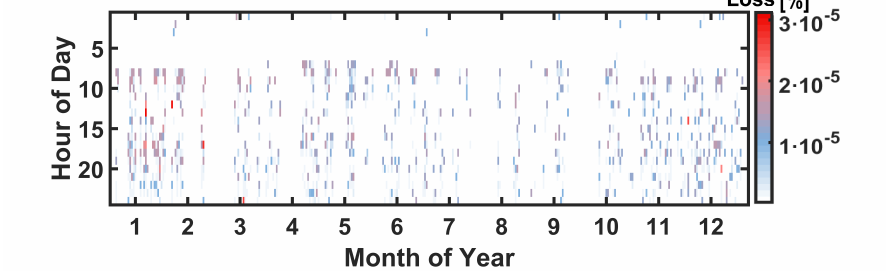
Figure 24. Hourly mean total loss increment for Scheme 2 (Conv-PEG).